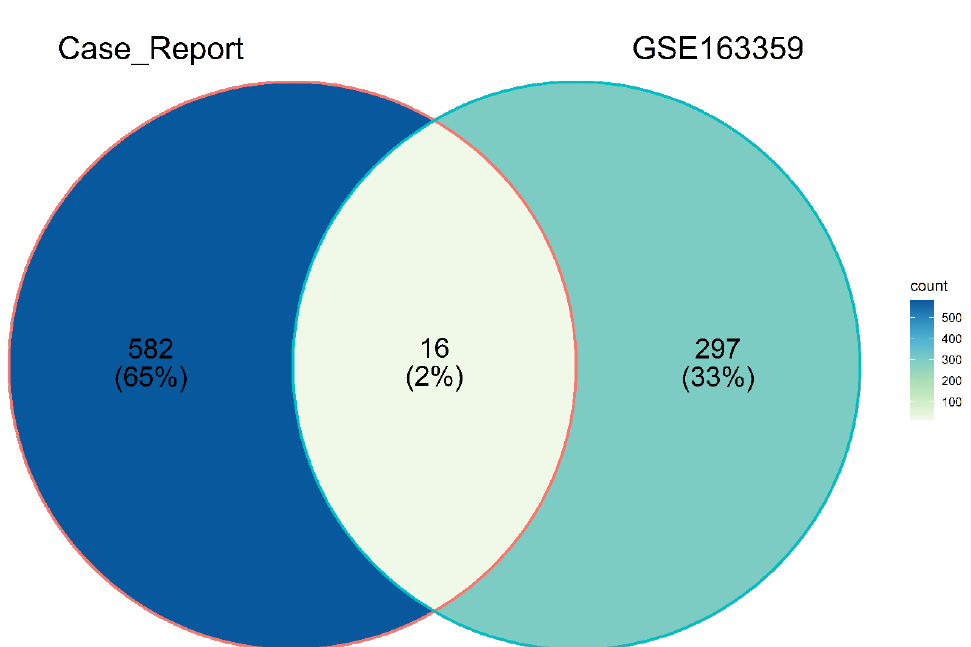
Figure 7. Venn diagram of the genes that overlap in the expression signatures of the two datasets studied.